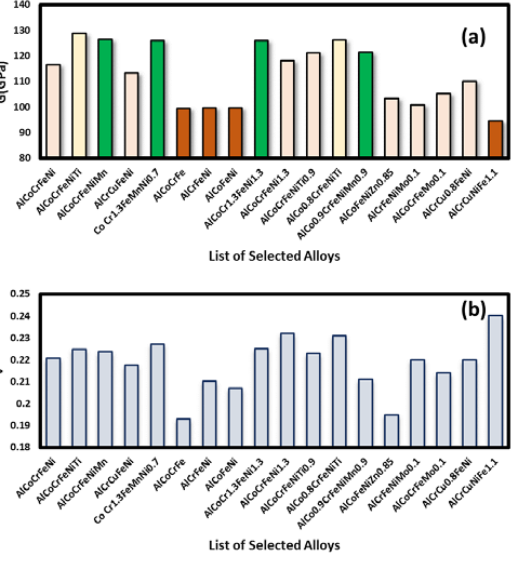
Figure A8. ( a ) Shear modulus (G) and ( b ) Poisson’s ratio ( ν ) for selected alloys. Alloys shown in green bar are titanium free but elastic constants are not very different from titanium-based alloys (shown in yellow bar). Red bars are for low performance alloys.